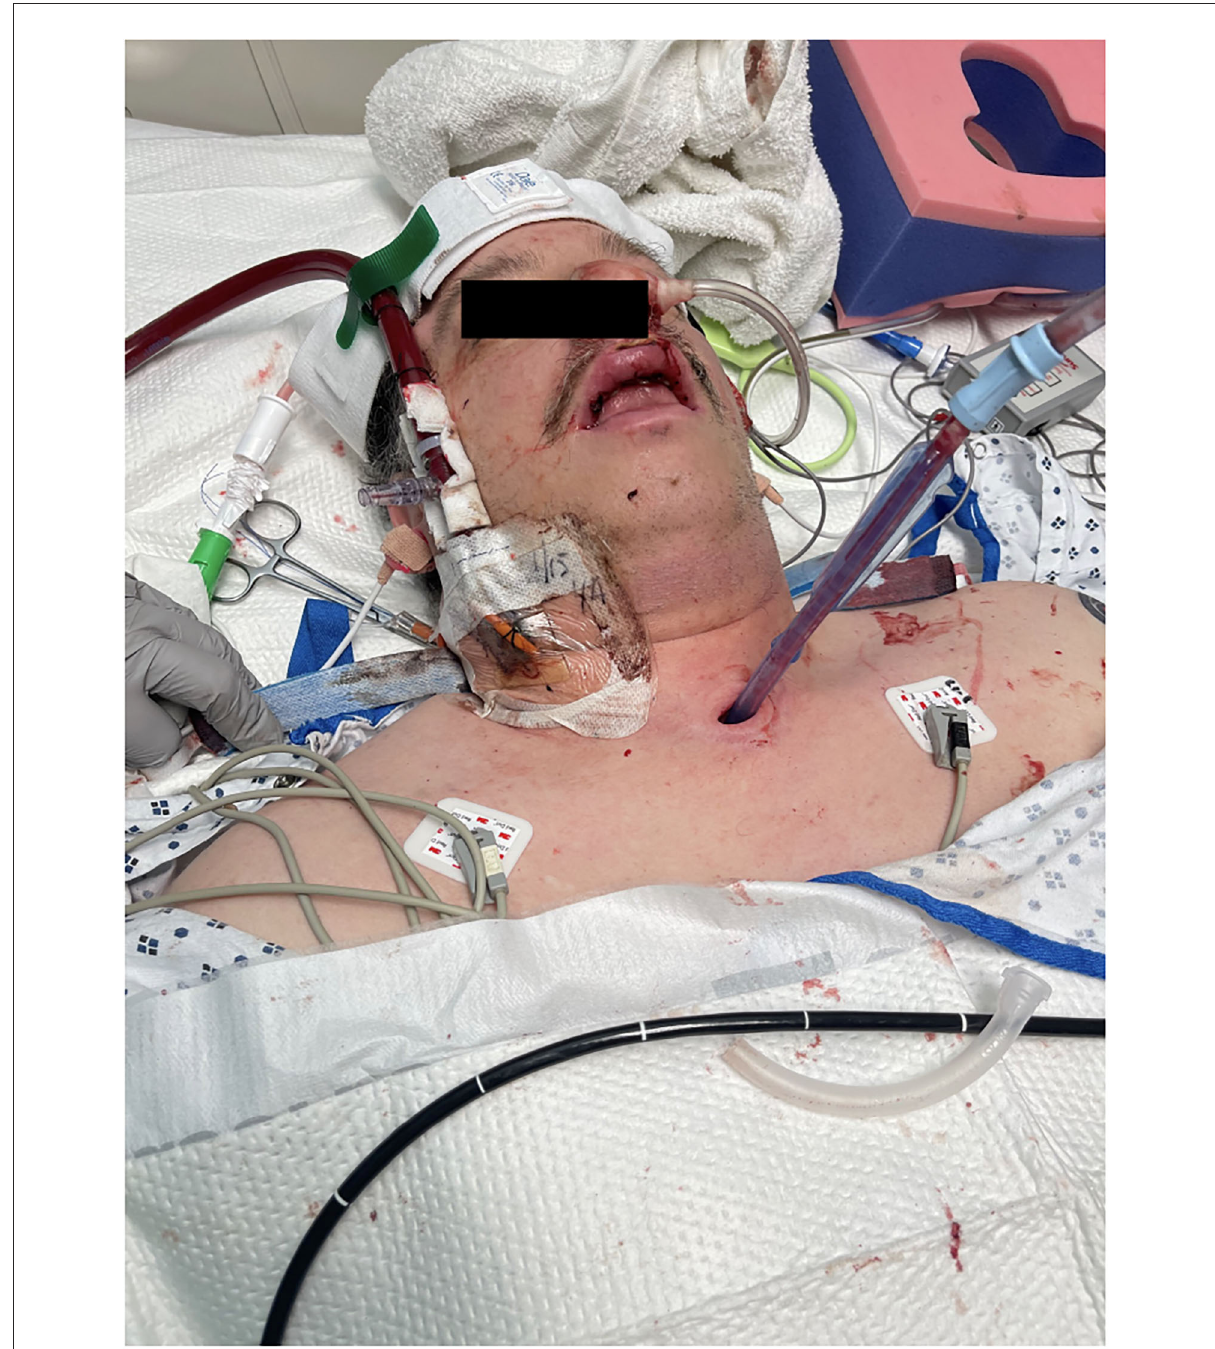
FIGURE3 Tracheostomy tube was removed, and direct suction was performed from tracheal stoma using Yankauer catheter.